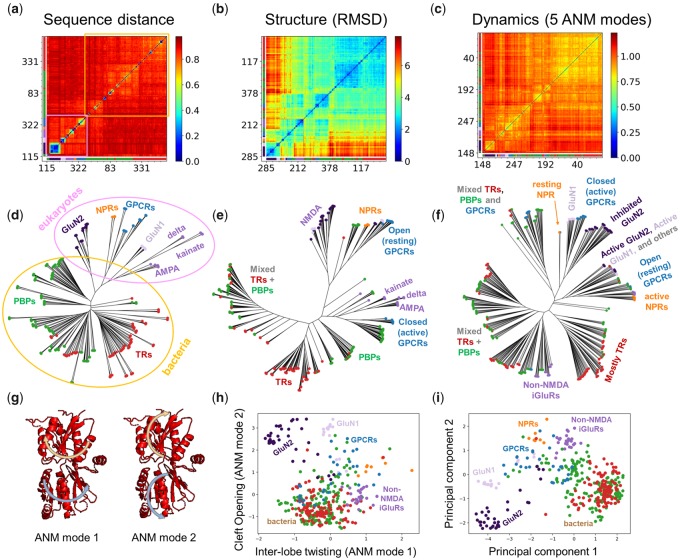
Categorization of family members based on their sequence, structure, and dynamics. (a–f) Distance matrices (a–c) and corresponding dendrograms (d–f) for PBP-1 family members based on (a and d) Hamming distance between sequences, (b and e) RMSD between structures and (c and f) spectral distance between global ANM modes (k = 5). The numbers and colors along the axes correspond to the order of the conformers based on RMSD clustering and the subfamilies to which they belong (see supplementary table S2, Supplementary Material online). In the trees, each node represents a member and the colors and labels correspond to subfamilies along with conformational/functional states. In the sequence case (a and d), there is a clear distinction between bacteria and eukaryotes, highlighted in blue and orange, respectively. (g) The first two global signature ANM modes are shown with arrows illustrating the opposite motions of the upper and lower lobes. Mode 1 (left) shows a twisting/untwisting motion and mode 2 (right) shows an opening/closing motion as shown in supplementary movies 1 and 2, Supplementary Material online. (h) Projection of family members onto a 2D space spanned by the first two signature ANM modes clusters family members based on global mode spectra akin to panels (c) and (f). (i) Projection of family members onto a 2D space spanned by the first two principal components of structural variation clusters family members akin to panels (b) and (e).